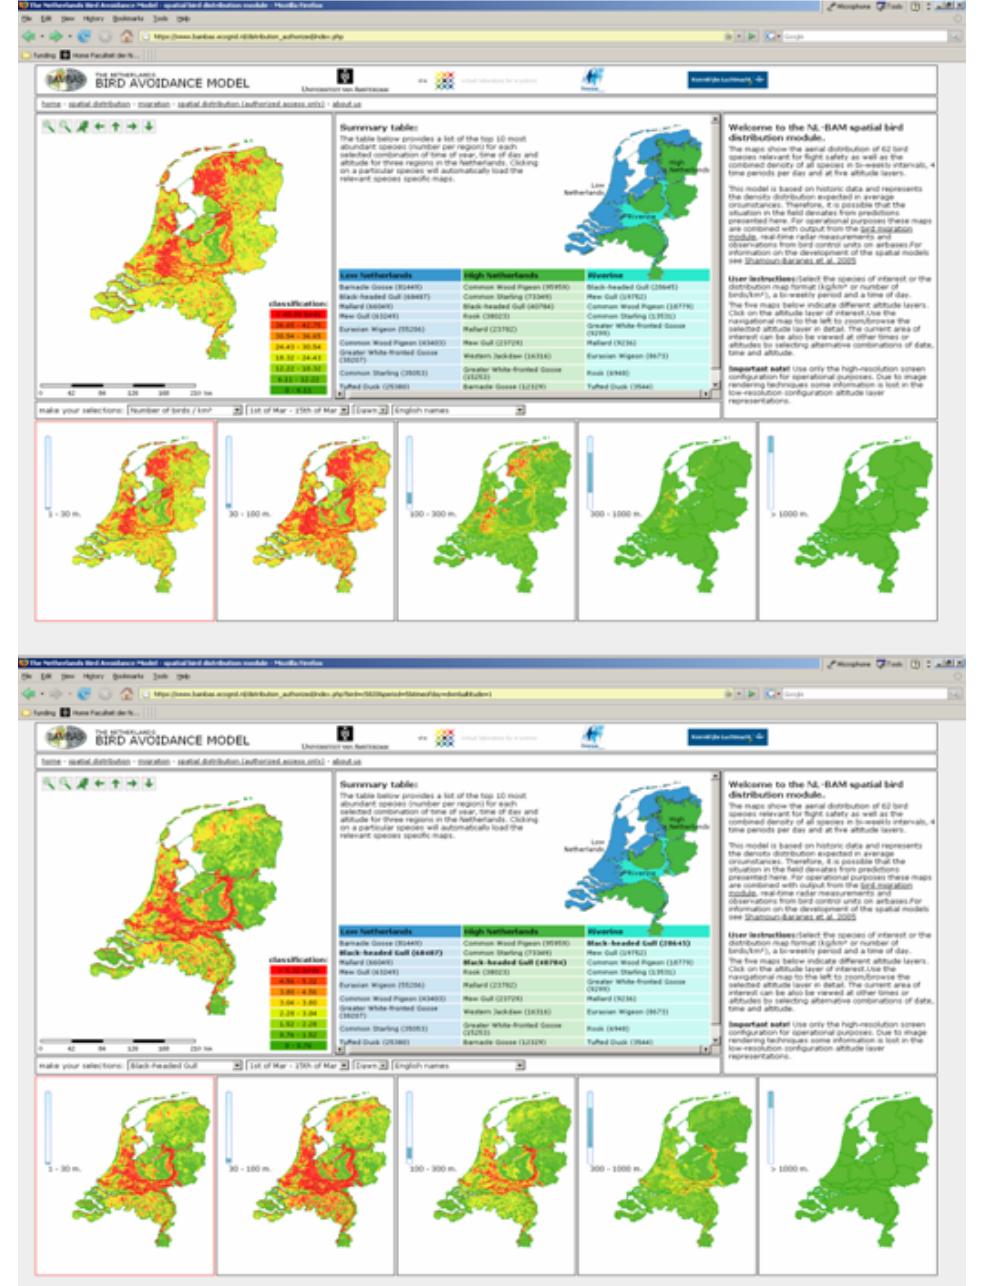
Fig. 3. Screenshots from the spatial distribution module of the Netherlands bird avoidance model. Upper screenshot is of birds/km² at different altitudes from 1–15 March during dawn. The lower screen shot is the distribution of black-headed gulls ( Larus ridibundus ) in the air, one of the most abundant species during this time of day and